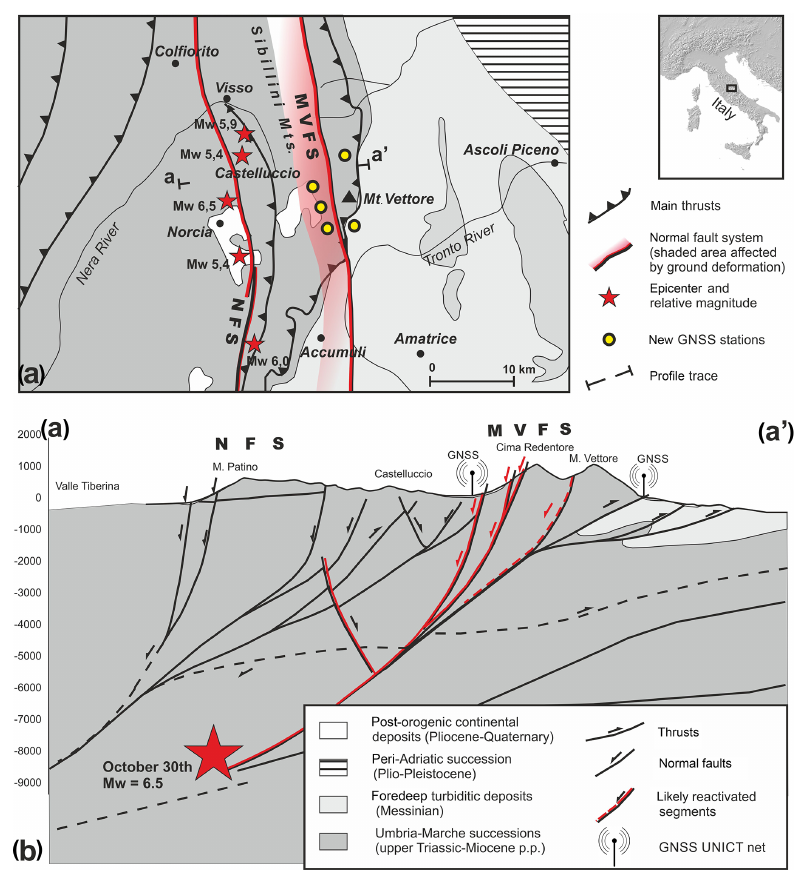
Figure 1. Simplified seismotectonic map of the central Apennines (a) and geological profile across the epicentral area (b) . The location of the major event (30 October) is from GdL INGV (2016), while the main geostructural features from Pierantoni et al. (2013) and Mantovani et al. (2011) have been